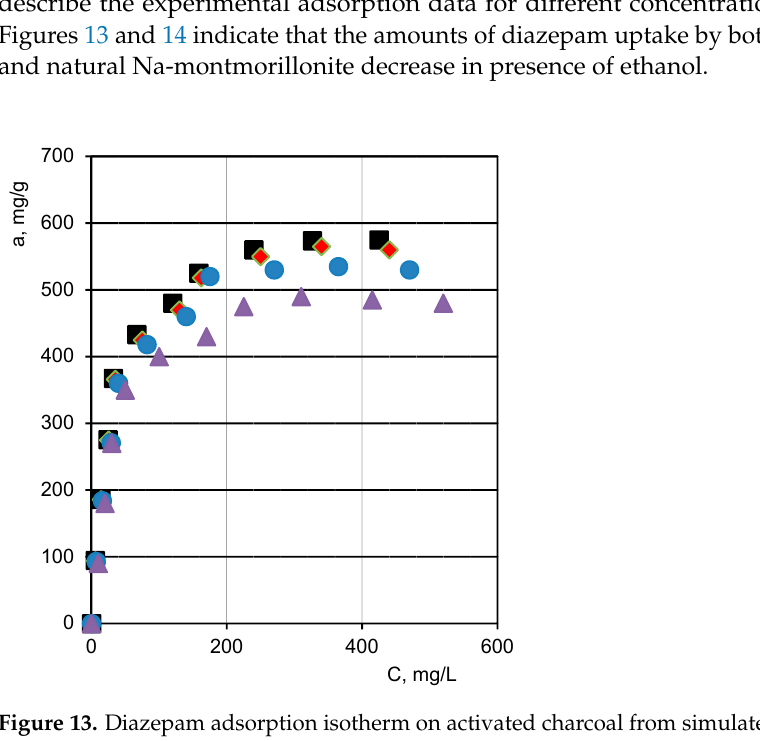
Figure 12. Influence of pH on diazepam sorption by activated charcoal; T = 37.0 ± 0.1 °C; Ci = 0.7 mg/mL; and S:L ratio = 1 g/L.